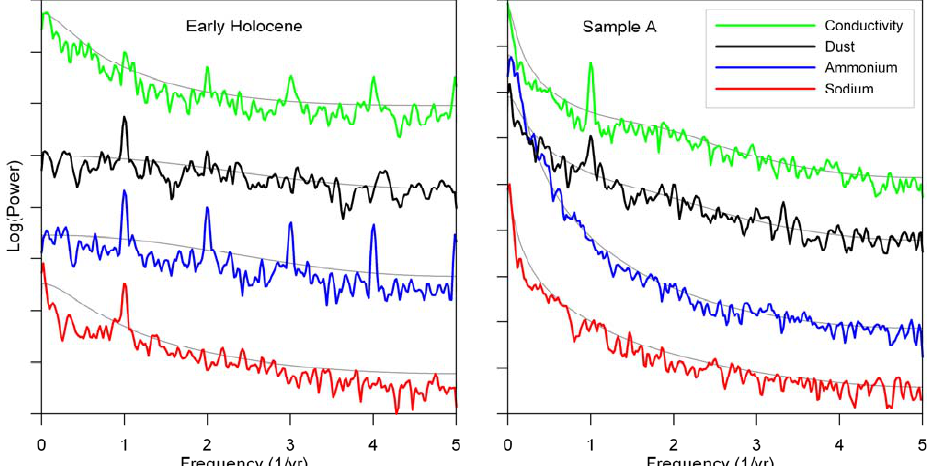
Fig. 6. Time domain power density spectra comparing early Holocene and Eemain (sample “A”) NGRIP impurity records. The records were placed on a floating time scale based on annual layer counting. The early Holocene sample covers a 11.0m ice core section (1378.30– 1389.30m depth about 10 b2k) in which 148 certain annual layers were identified (from Bigler et al., 2011). Sample “A” covers a 2.2m core section in which 190 annual layers have been identified (Table 3). Both ‘certain’ and ‘uncertain’ annual layers are included. Grey lines indicate 95% confidence limits from simulation of noise spectra. The spectra have been shifted vertically for clarity, but all spectra have comparable units. Larger missing sample sections were skipped, whereas shorter data gaps have been linearly interpolated. FIGURE 7.